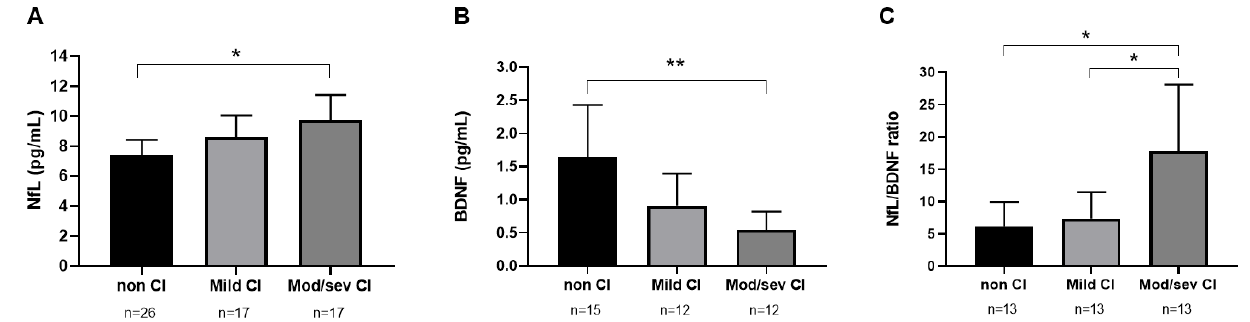
Figure 3. Plasma concentrations of neurofilament light chain (( A ), NfL), Brain-derived neurotrophic factor (( B ), BDNF) and ratio of NfL/BDNF ( C ) according to cognitive impairment in SUD patients. Data were analyzed by one-way analysis of covariance (ANCOVA). Bars are estimated marginal means and 95% confidence intervals representing. * p < 0.05 and ** p < 0.01 denote a significant main effect of the cognitive impairment factor. CI = cognitive impairment.